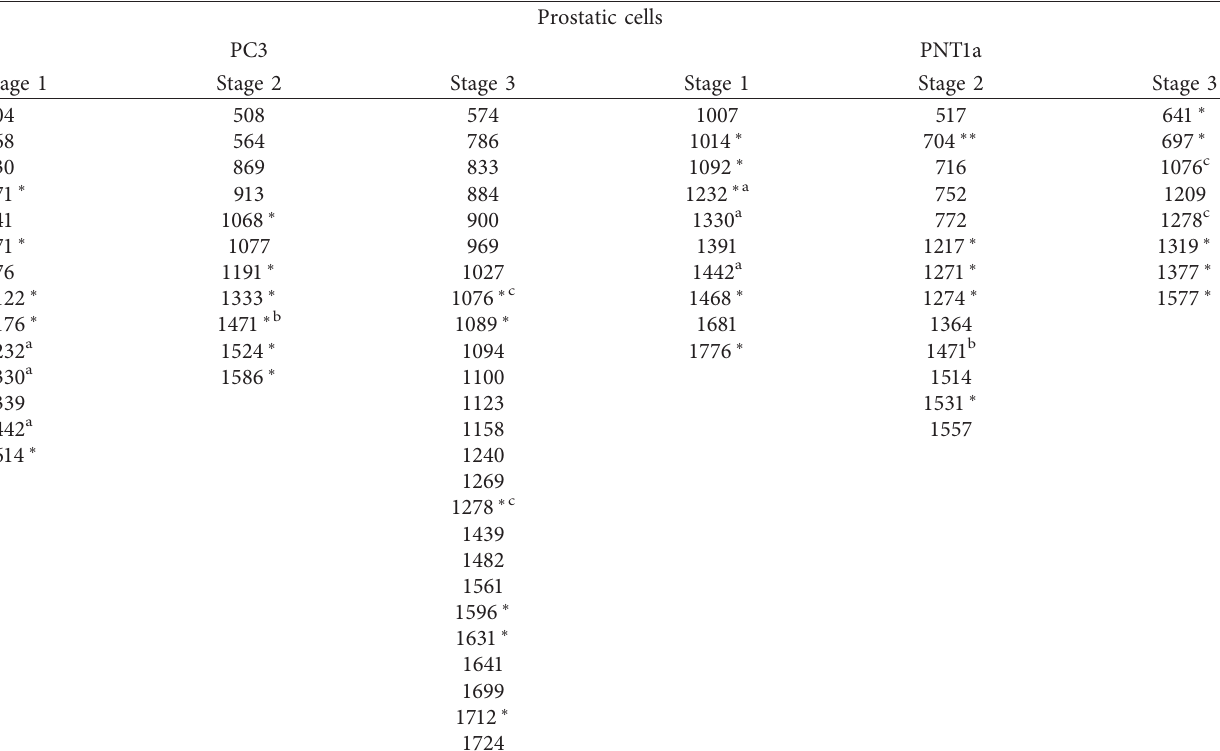
Table 5: The Raman bands (loading vectors) that explain natural groupings of PNT1a and PC3 scores using PC 5 (0.03%) for stage 1, PC 8 (0.02%) for stage 2, and PC 5 (0.01%) for stage 3